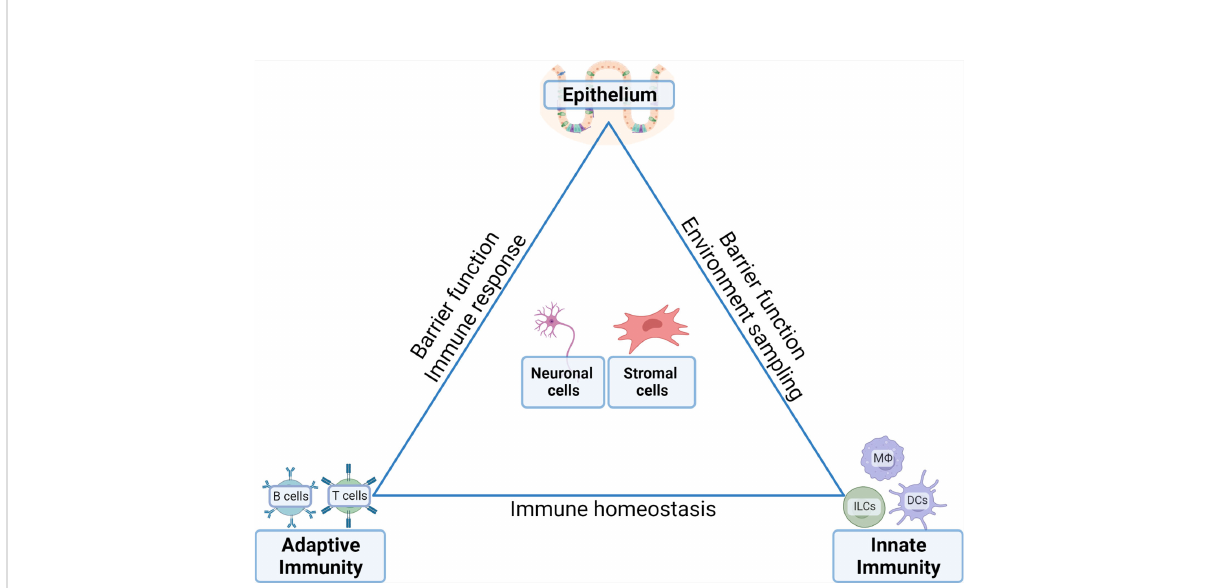
FIGURE 1 Communication between distinct cell compartments ensures tissue homeostasis in the gut. The complex function and need for rapid adaptability to external stimuli (i.e. food, water, bacterial load and products, enteric signals) requires carefully balanced and controlled equilibria between the epithelia, the innate immune compartments, the adaptive immune compartments and their reciprocal interactions with enteric neuronal network and stromal cells. In fl ammatory conditions arise in situations where the balances are skewed by epithelial signals that stimulate the immune compartments and a disbalance between the innate and adaptive compartments. In neoplastic situations, the transformed epithelium feeds of the cytokine-rich environment established by the immune compartments including the establishment of an immune suppressive bias towards anti-tumor immunity conferred by tumor-eradicating effectors